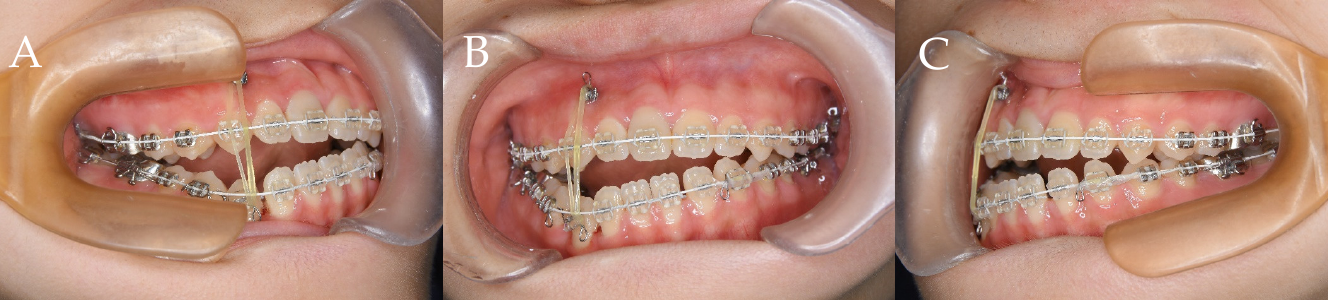
Figure 7. Retraction of the ankylosed lower right canine using intermaxillary elastics. ( A ) Right side view; ( B ) front view; ( C ) left side view.